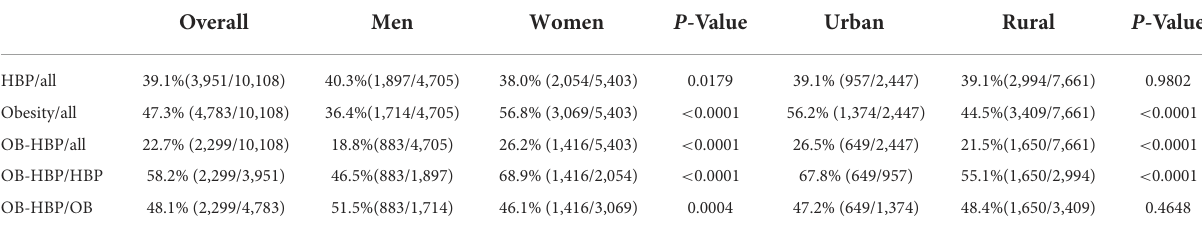
TABLE 2 The prevalence of obesity, hypertension, obesity-related of hypertension among men, women, urban and